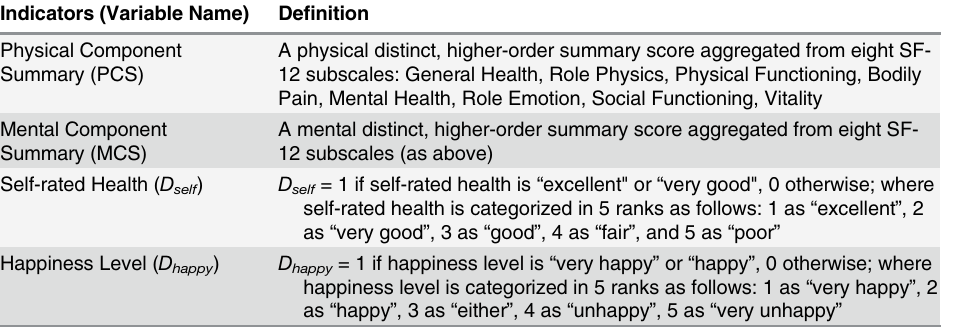
Table 1. Indicators of Health